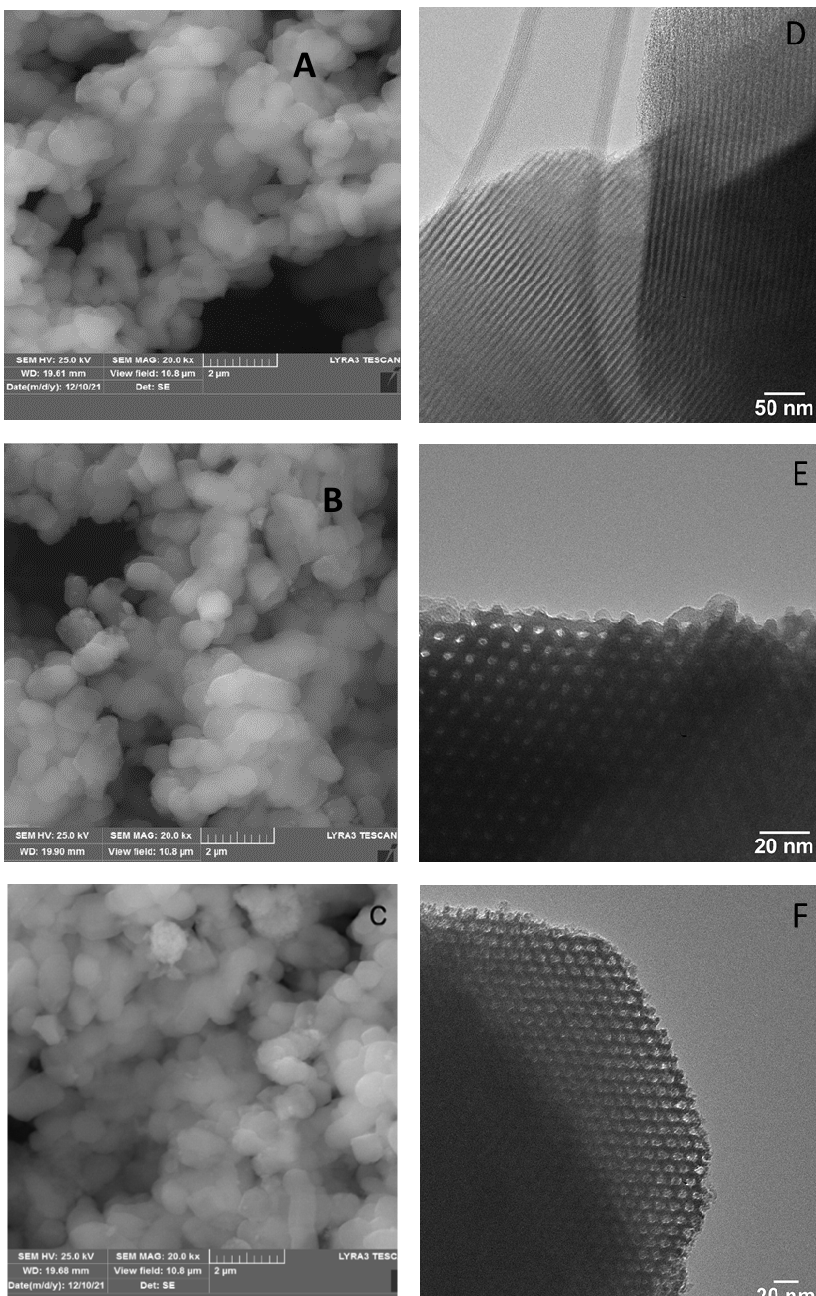
Figure 4. SEM images of SBA-15 ( A ), SBA-NBDH ( B ), and SBA-NBD-PD ( C ) and TEM images of SBA-15 ( D ), SBA-NBDH ( E ), and SBA-NBD-PD ( F ).